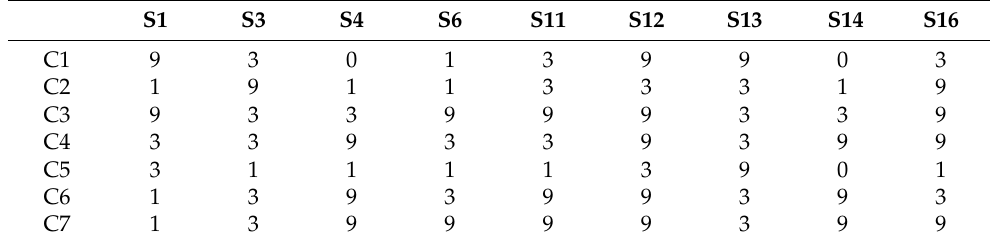
Based on the results from Table 3, nine stages have been selected, considered sufficient to cover the requirements of the problem. They are reflected in Table 4. The selection was based on having at least a strong connection between each row and each column. The performance of the adapted Bézier curve algorithm was further tested for the nine selected stages. According to the results from Table 4, each selected stage can be seen online in a video in Appendix A. Table 4. The nine scenarios selected for testing the